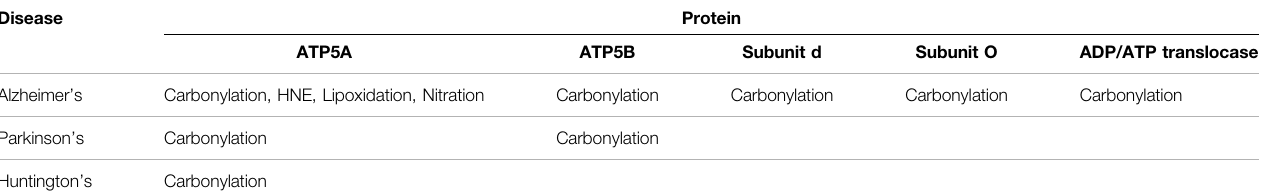
TABLE 1 | The different oxidative modi fi cations of ATP synthase reported in Alzheimer ’ s disease, Parkinson ’ s disease, and Huntington ’ s disease.